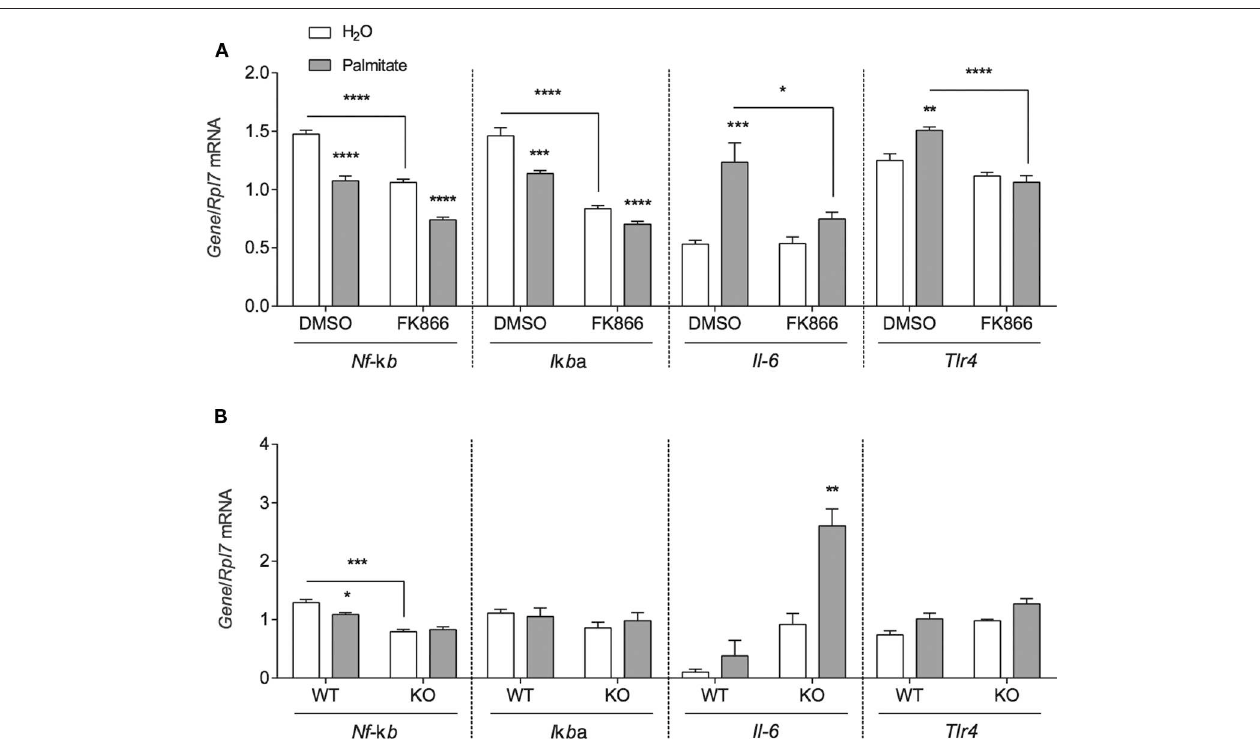
FIGURE 4 | NAMPT and BMAL1 are involved in the induction of inflammatory gene expression by palmitate. (A) mHypoE-46 neurons were pretreated for 1h with 10nM FK866 or DMSO vehicle control then treated with 50 µ M palmitate for 24h. (B) mHypoA-BMAL1-WT/F and mHypoA-BMAL1-KO/F cells were treated with 50 µ M palmitate for 24h. Changes in Nf- κ b , I κ B α , Il-6 , and Tlr4 were assessed by qRT-PCR. n = 3–4 independent experiments. Data are expressed as mean ± SEM, * P < 0.05,** P < 0.01,*** P < 0.001,**** P < 0.0001. Statistical analysis was performed by two-way ANOVA with the Tukey post hoc